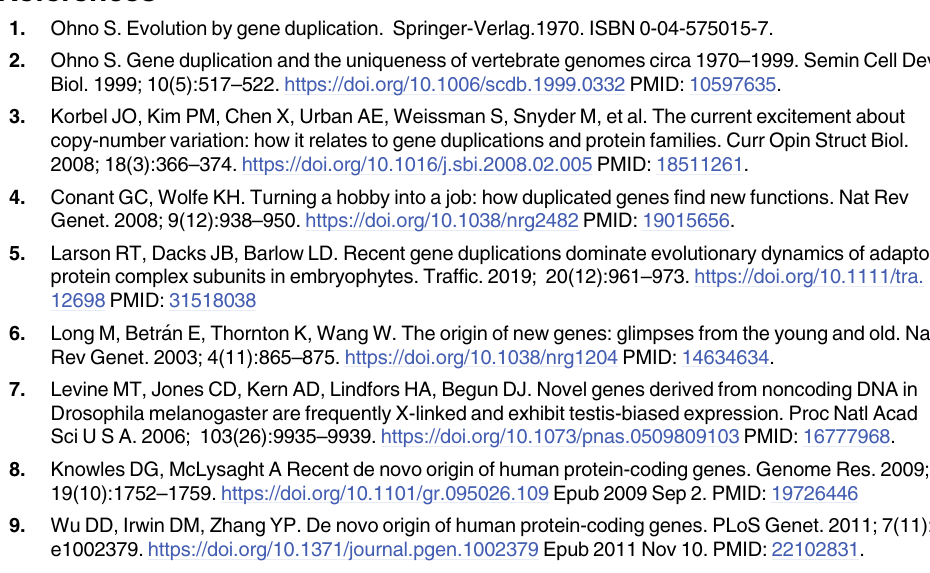
S12 Fig. RepeatMasker analysis of the FAM247 sequence and Secondary structure predic- tions of FAM247 imperfect